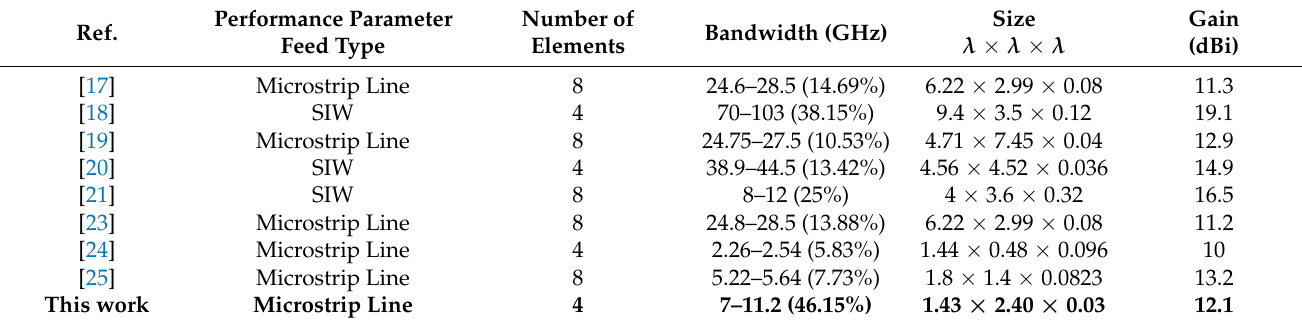
Table 4. Comparison of results from some previous antenna arrays in the